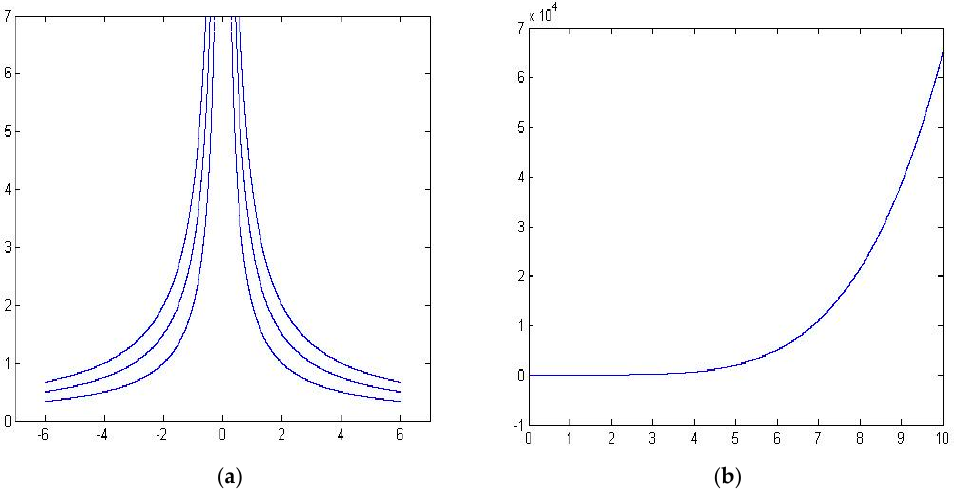
Figure 10. The performance of interpolation and extrapolation for the fluid flow around an infinite wall. ( a ) Particle paths obtained by our method, ( b ) The error curve.